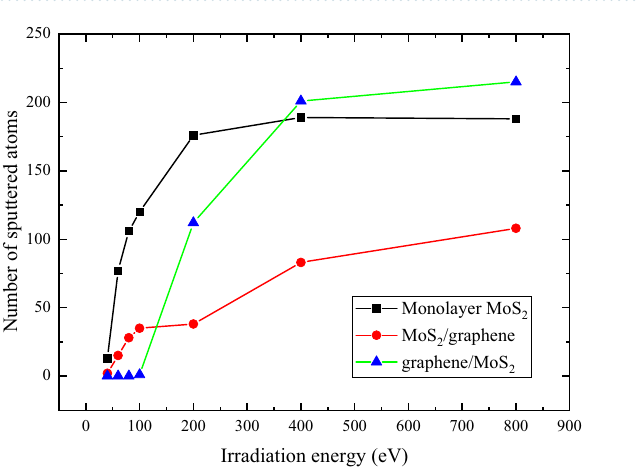
mostly relieve the irradiation damage onto bottom-layer MoS 2 , while in MoS 2 /graphene heterostructure, it is the interaction between bottom-layer graphene and top-layer MoS 2 weakening the irradiation damage onto MoS 2 . If the irradiation energy is increased to 400 eV, it is found that the bottom graphene can still reduce the irradiation effect of MoS 2 . While for the graphene on top (graphene/MoS 2 case), the irradiation damage is more severe, which is attribute to the indirect collision from the sputtered carbon atoms in top graphene layer. For the top-layer 2D crystal, the switch from protective effect to destructive effect at different energy levels corresponds to the results in Fig. 3. Figure 5 gives the variation of the number of sputtered atoms (atoms being knocked out of the 2D plane) in MoS 2 layer under different irradiation energies for the aforementioned three cases. It clearly shows that the